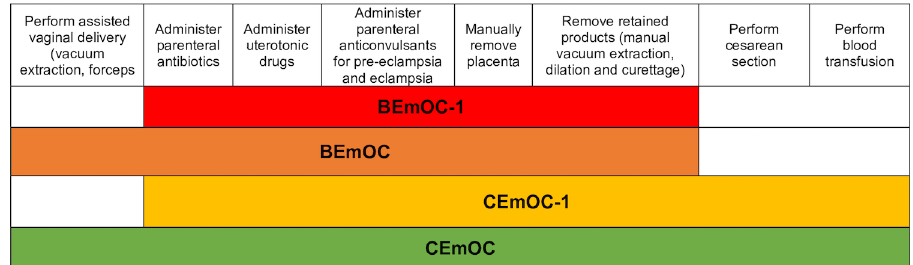
Fig 1. Signal functions and classifications used to identify basic and comprehensive emergency obstetric care. BEmOC includesassisted vaginaldelivery,administration of parenteralantibiotics, administration of uterotonic drugs, administration of parenteralanticonvulsants, manual removalof placenta and removalof retainedproducts. BEmOC-1 includesall BEmOC functions except assisted vaginaldelivery. CEmOC includesall BEmOC functions in additionto cesareanand blood transfusioncapabilities. CEmOC-1 includesall CEmOC functions except assisted vaginaldelivery [5–6].